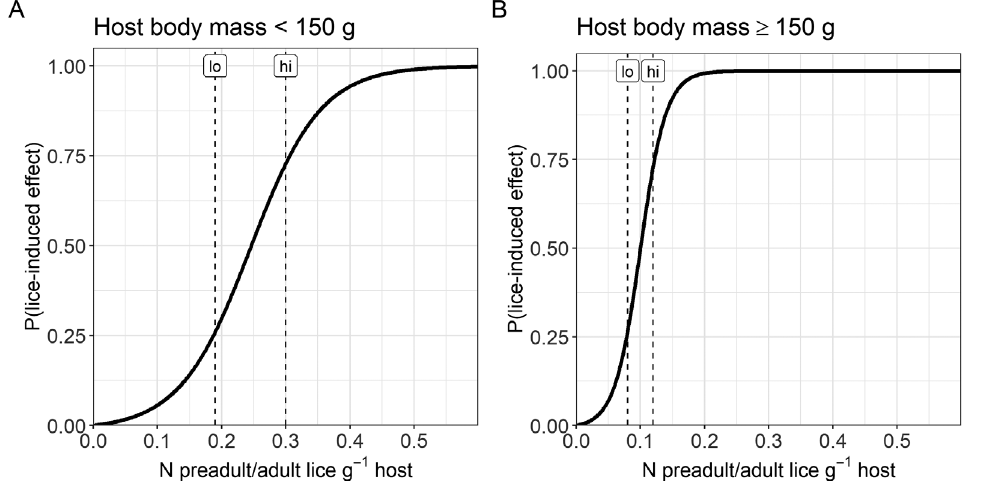
Fig. 3. Lice response curves (probability of a lice-induced effect as function of number of preadult/adult lice g −1 host body mass) for hosts with body mass (A) <150 g and (B) ≥150 g. In (A), lo = 0.19 and hi = 0.30; in (B), lo = 0.08 and hi = 0.12